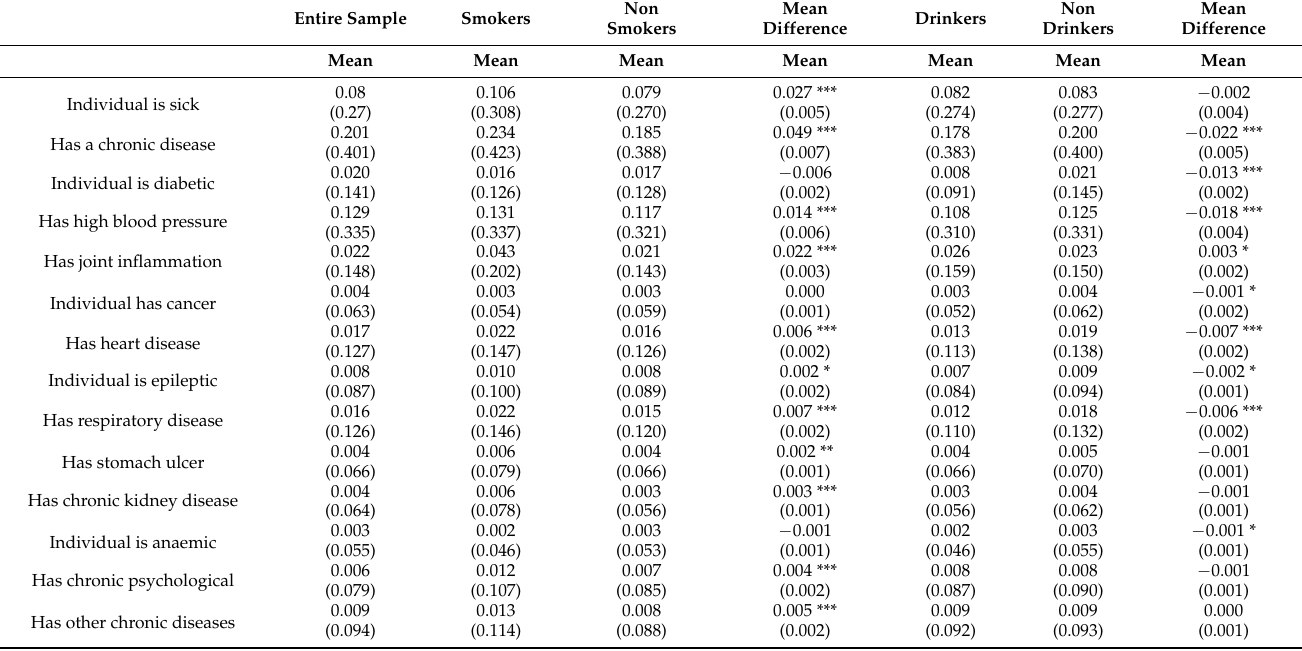
Table 1. Mean health and differences in mean health by smoking and drinking